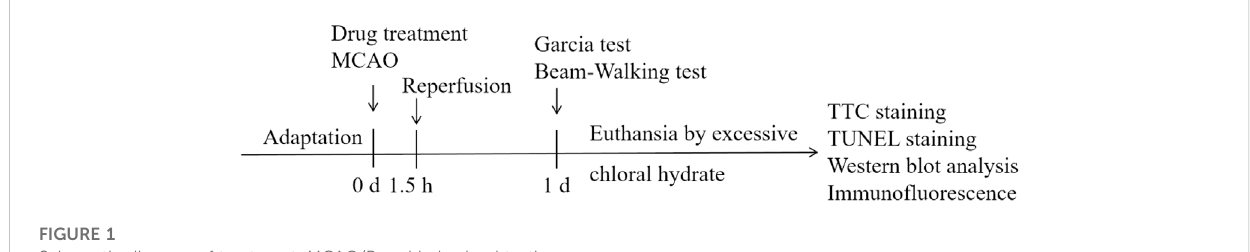
Schematic diagram of treatment, MCAO/R and behavioral